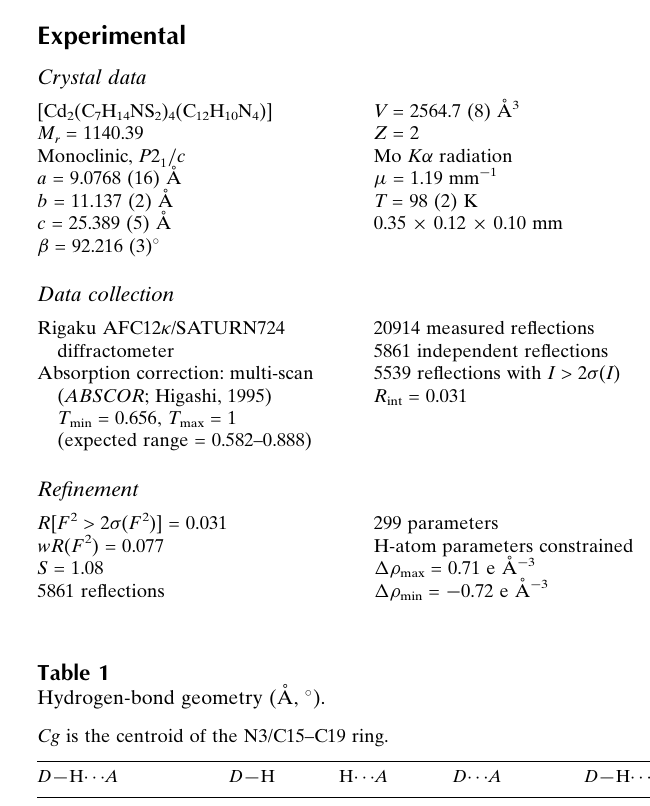
The dinuclear centrosymmetric compound,